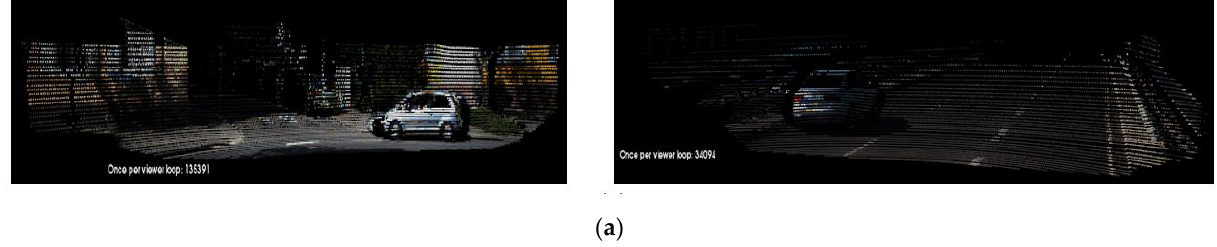
Figure 3. Acquired data by a vehicle at a moment of motion. ( a ) The FOV images; ( b ) The lidar 3D point cloud.